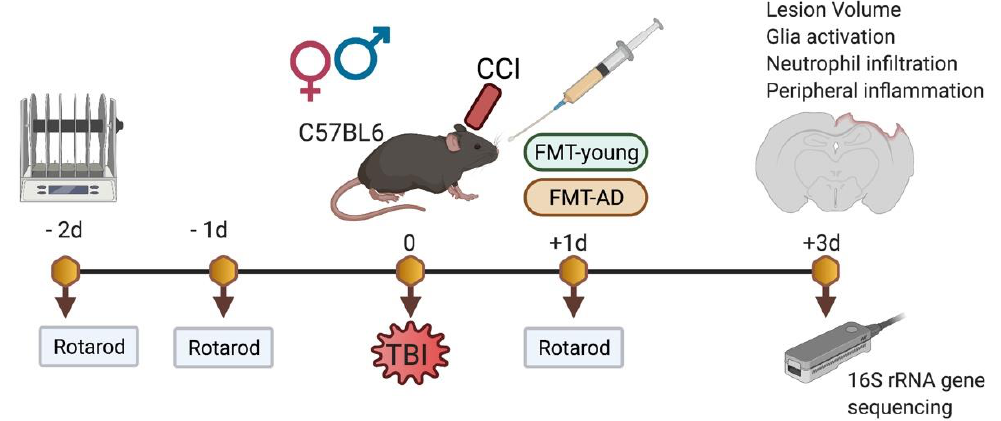
Figure 1. Experimental design. The controlled cortical injury (CCI, a model of TBI) was performed on WT mice. FMT-young and FMT-AD groups received fecal matter transplants by oral gavage from young WT and aged 3 × Tg-AD mice, respectively. Motor performance on the rotarod test was assessed before the injury and at 1 day post-TBI. Brains, blood, and colon samples were collected 3 days post-TBI for immunohistochemical and molecular characterization. Gut microbiome composition from cecal contents was analyzed by 16S rRNA gene sequencing using the Nanopore platform.